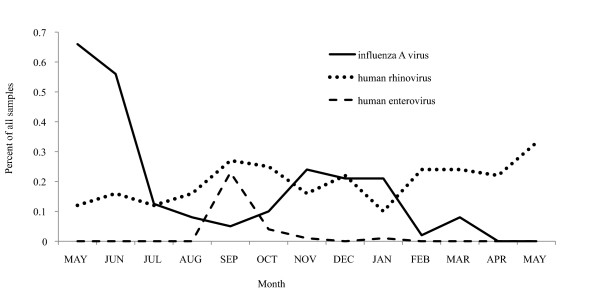
Monthly incidence of influenza A virus, human rhinovirus and human enterovirus. Each data point is shown as a percentage of all samples screened during that month.